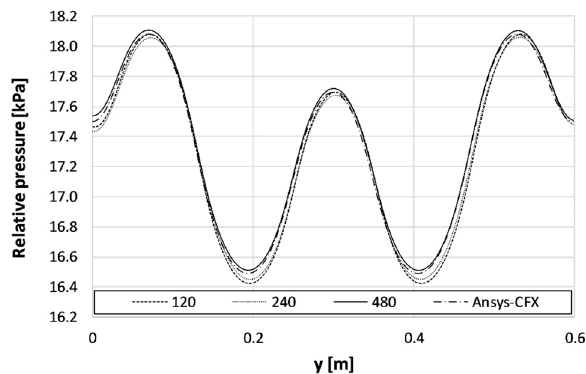
Figure A3. Single undeformed channel in the counter flow configuration at P in = 18.64 kPa: pressure profiles along a line orthogonal to the main flow direction and located 2 cm away from the inlet, see Figure 8b. Results obtained with three grids of increasing resolution are compared with CFD predictions.